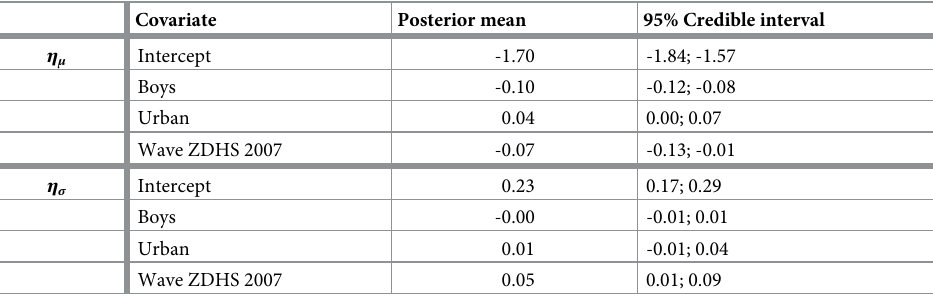
Table 6. Estimation results: Linear effects of Model